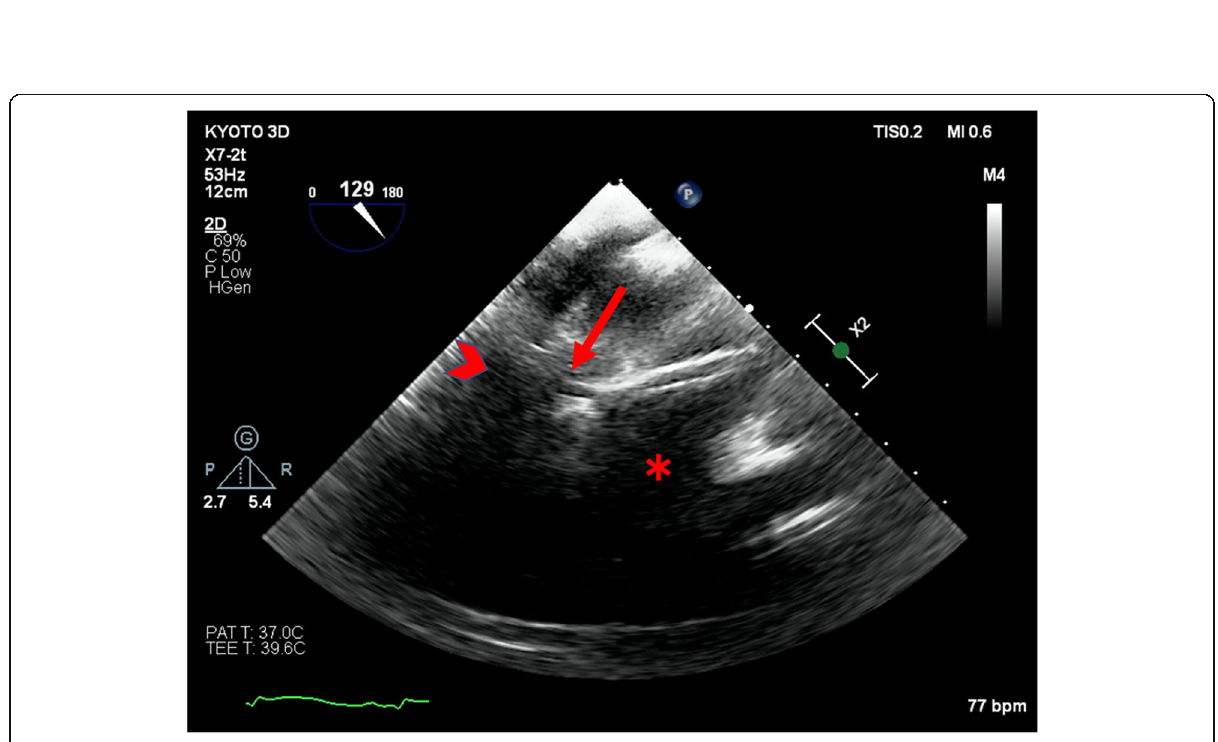
Fig. 3 A straying tip of the IMPELLA® in the left ventricle apical wall detected by transgastric long-axis view by transesophageal echocardiography. Note the massive pericardial effusion (arrow head) and the two highly echogenic parallel lines indicating the tip of the IMPE LLA® and the thinning left ventricular apical wall (small arrow). Left ventricle anteroseptal wall was not depicted probably because of acoustic shadow of the IMPELLA®